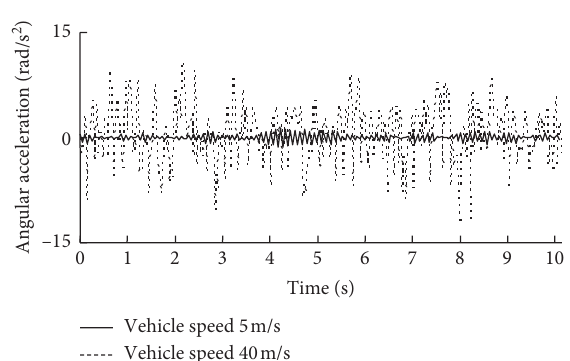
Figure 17: The time-history curves of rolling vibration accelera- tions of the vehicle body.